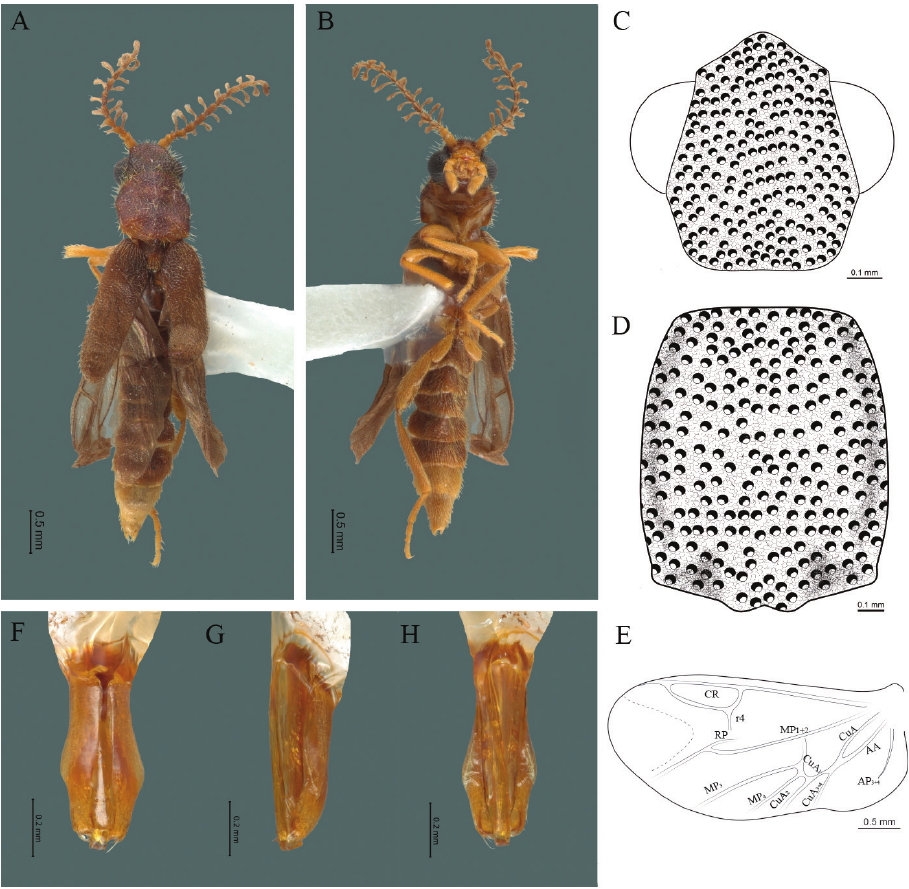
Figure 22. Cenophengus niger Wittmer, 1986, male. Habitus: A dorsal B ventral C head dorsal D pronotum dorsal E hind wing. Wing venation: CR = Radial Cell; r4 = radial 4 vein; RP = Posterior Radial vein; MP1+2 = Posterior Median vein; CuA = Cubital vein; AA and AP = Anterior and Posterior Anal veins. Aedeagus: F dorsal view G lateral view H ventral